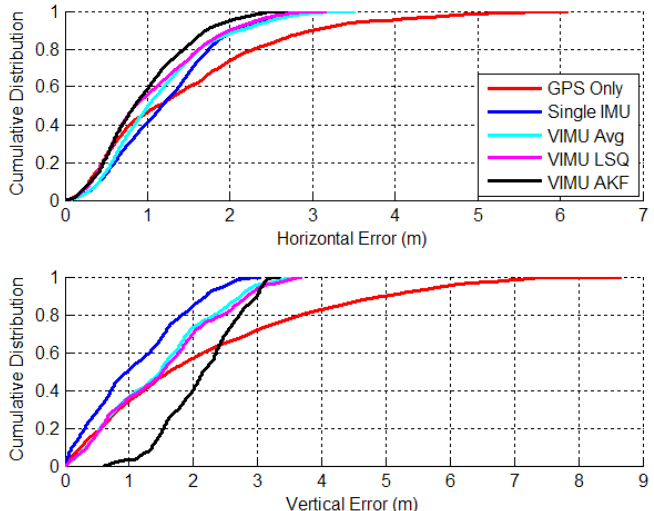
Figure 8. CD of Horizontal and Vertical Errors (Residential Data